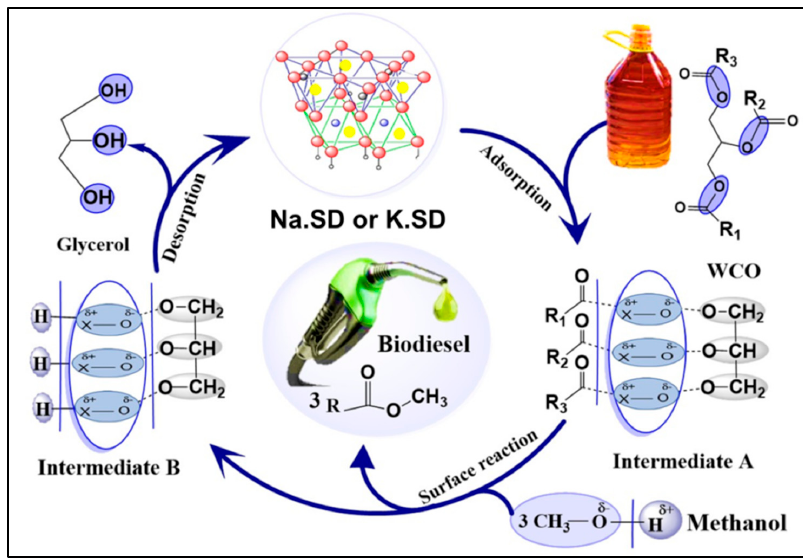
Figure 4. Schematic diagram of the transesterification of waste cooking oil into biodiesel using the synthetic Na.SD and K.SD catalysts.